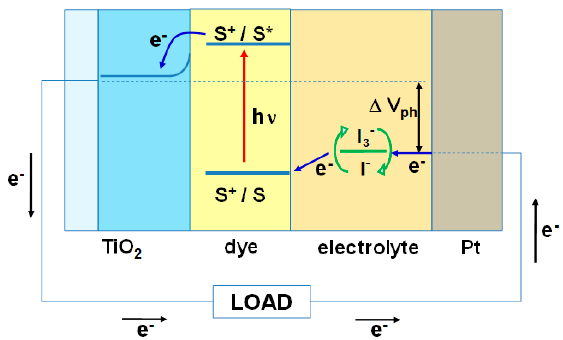
Figure 11. Schematic diagram on working mechanism of DSCs. Reprinted with permission from [38].